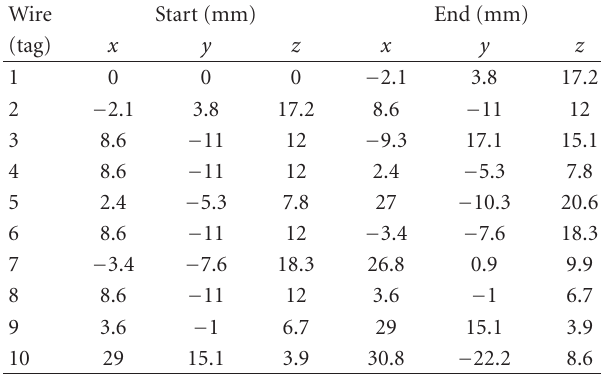
Table 1: Coordinates (in mm) for the C = 20 GP-optimized antenna. All wires have a radius of 1